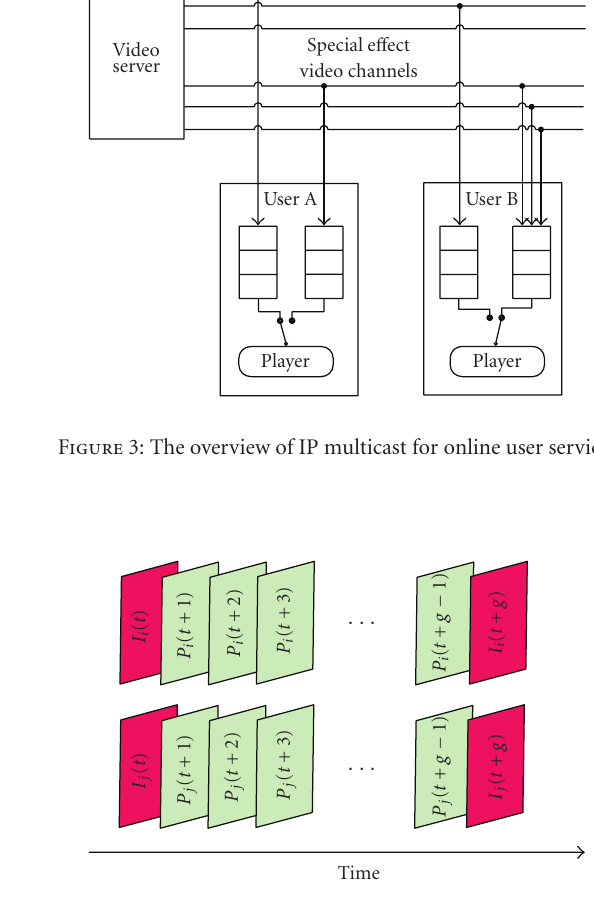
Figure 4: Conventional video channels. Here g is the value of GOP